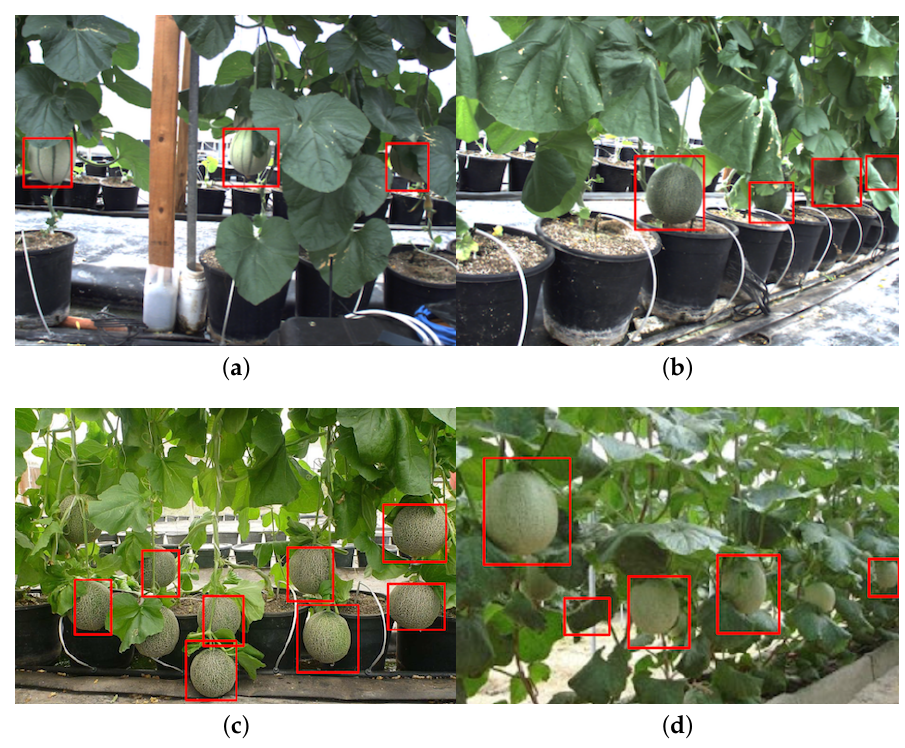
Figure 16. Four instances of rock melon detection. ( a ) and ( b ) are obtained from a farm site using a JAI camera, and ( c ) and ( d ) are from Google Images. Above each detection is the classification confidence output from the DCNN.